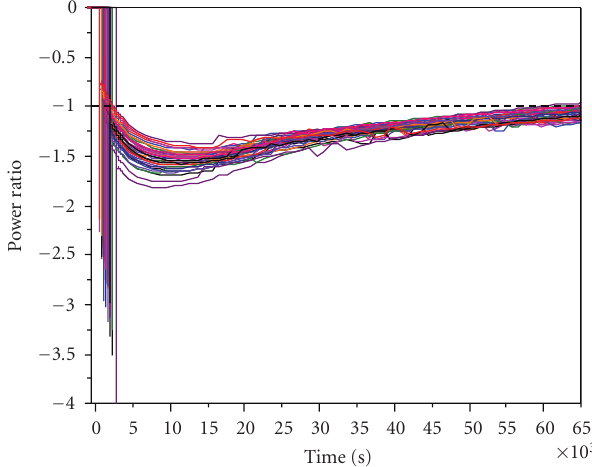
Figure 7: Power ratio evolution—long-term behavior (stochastic selected and nominal case).